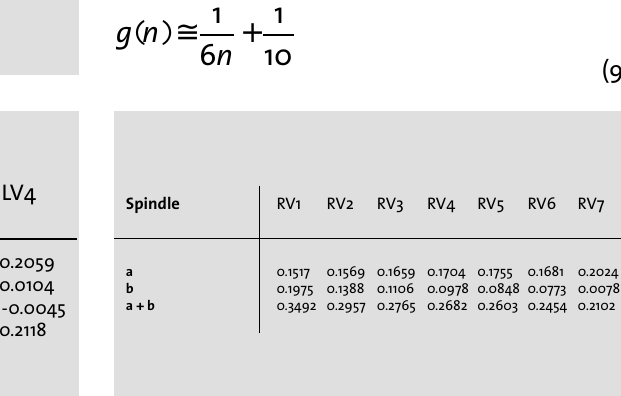
Table 7 (left above): Williams’ values of a, b and c for the various RV spindles. Also shown is the sum (a + b + c), which corresponds to n = 1. Table 8 (left below): Williams’ values of a, b and c for the various LV spindles. Also shown is the sum (a + b + c), which corresponds to n = 1. Table 9 (right below): Values of a, b and a + b connected with the simple